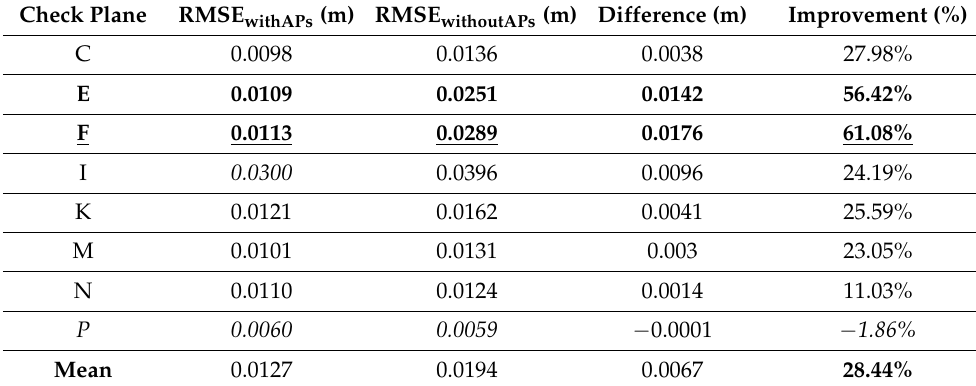
Table 12. RMSE of each check plane for dataset DATA2.